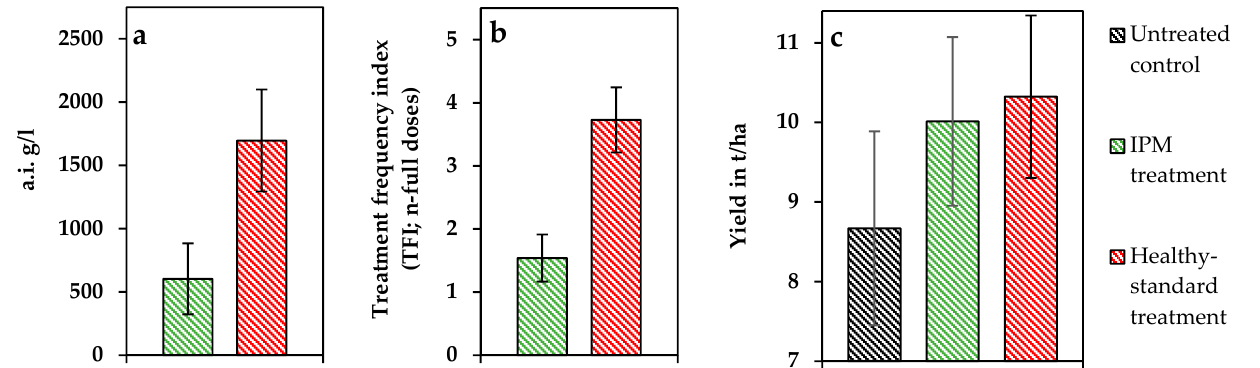
Figure 3. ( a ) Total use of fungicidial active ingredient (a.i) in the healthy-standard treatment and the IPM treatment (average in g per litre), ( b ) total treatment frequency index of the healthy-standard treatment and IPM treatment and ( c ) total yield (t/ha) of the untreated control, IPM treatment and healthy-standard treatment of winter wheat (cultivar “Ritmo”) at the eight trial locations in northern Germany from 1995 to 2021.